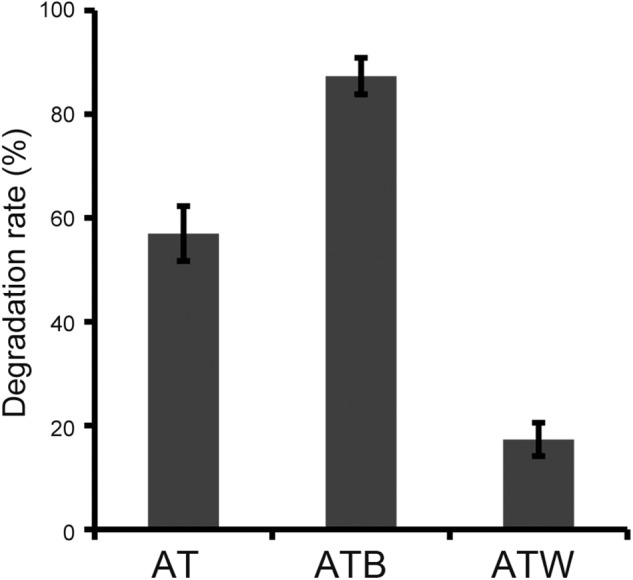
Degradation rates of 50 mg/l atrazine at 48 h by three enrichments at the same inoculum concentration. The data are the average of three replicates.